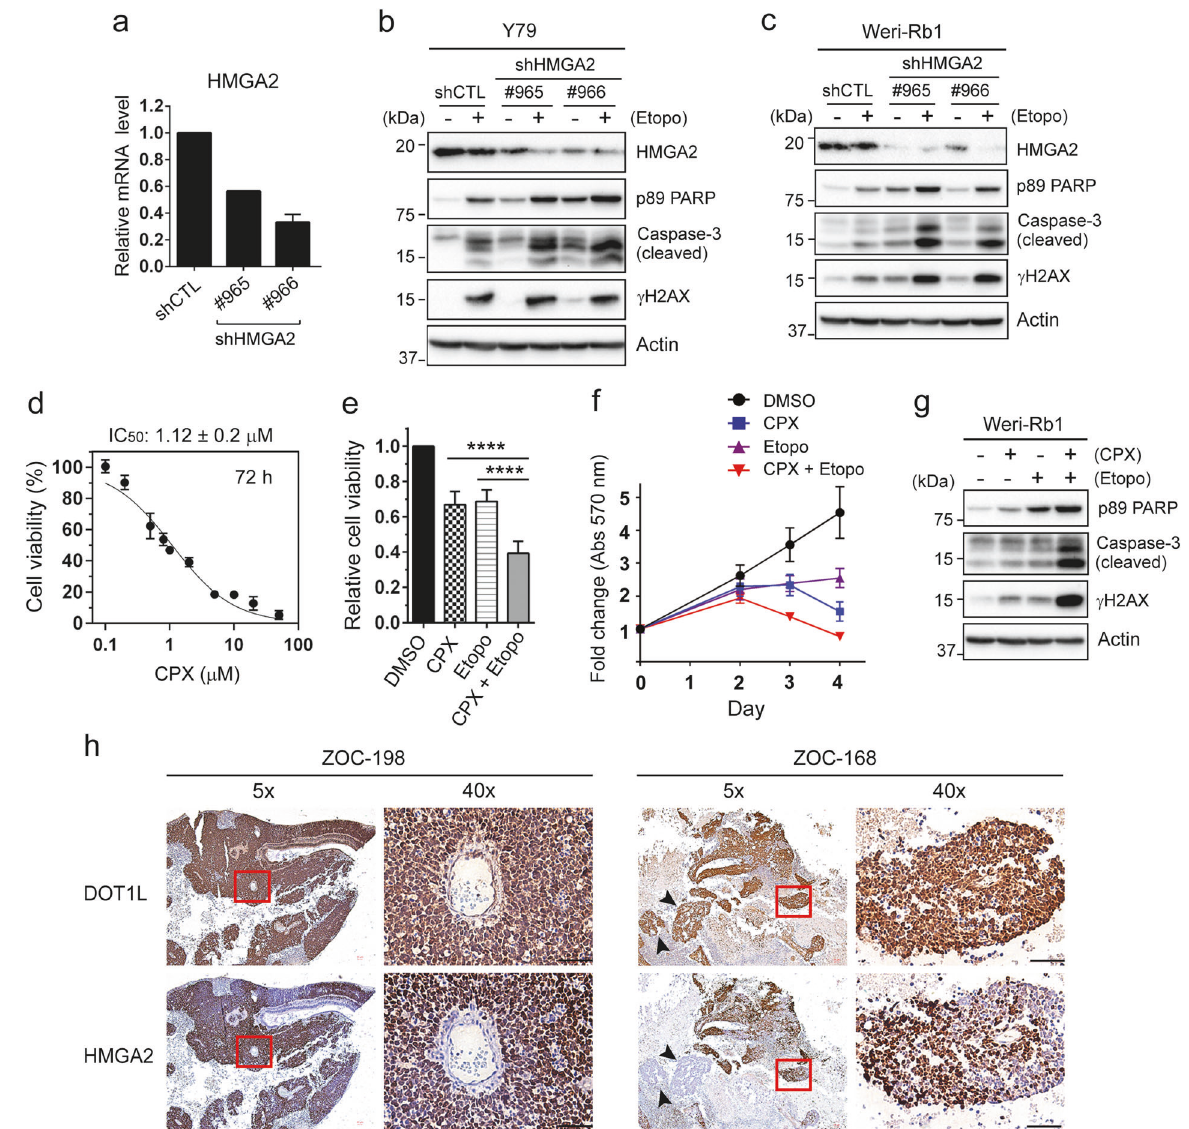
Fig. 5 HMGA2 downregulation contributes to the anticancer effects of DOT1L inhibition. a Lentiviral HMGA2 knockdown in Y79 cells determined by qRT-PCR ( N = 2). b , c Immunoblots for the indicated proteins in Y79 shHMGA2 cells treated with 10 µM etoposide for 24 h ( b ) and in Weri-Rb1 shHMGA2 cells treated with 0.5 µM etoposide for 20 h ( c ). d Dose-response study for the IC 50 of CPX in Y79 cells treated for 72 h by MTT assays. The IC 50 is shown as the mean ± SD ( N = 6). e , f MTT assays for relative cell viability and proliferation. Y79 cells were subjected to single or combined treatment of 0.5 µM CPX and 0.2 µM etoposide for 72 h to determine the relative cell viability ( e ) or up to 4 days to monitor the cell proliferation ( f ). The results are shown as the mean ± SD ( N = 6). **** P < 0.0001. g Immunoblots for indicated proteins in Weri-Rb1 cells treated with 2 µM CPX and 0.5 µM etoposide for 20 h. h Immunostaining of DOT1L and HMGA2 in human RB. Serial sections of the indicated tumor tissues were immunostained for DOT1L and HMGA2. The same region of the serial sections (marked by a red square) was magni fi ed on the right (×40). Arrowheads in ZOC-168 mark DOT1L + HMGA2 − tumor foci. Scale bar: 50 μ